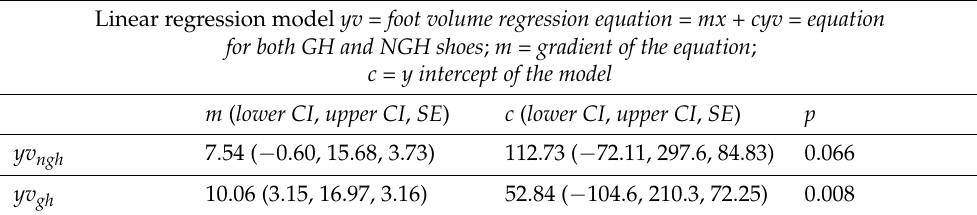
Figure 27. Graph of Foot Volume and